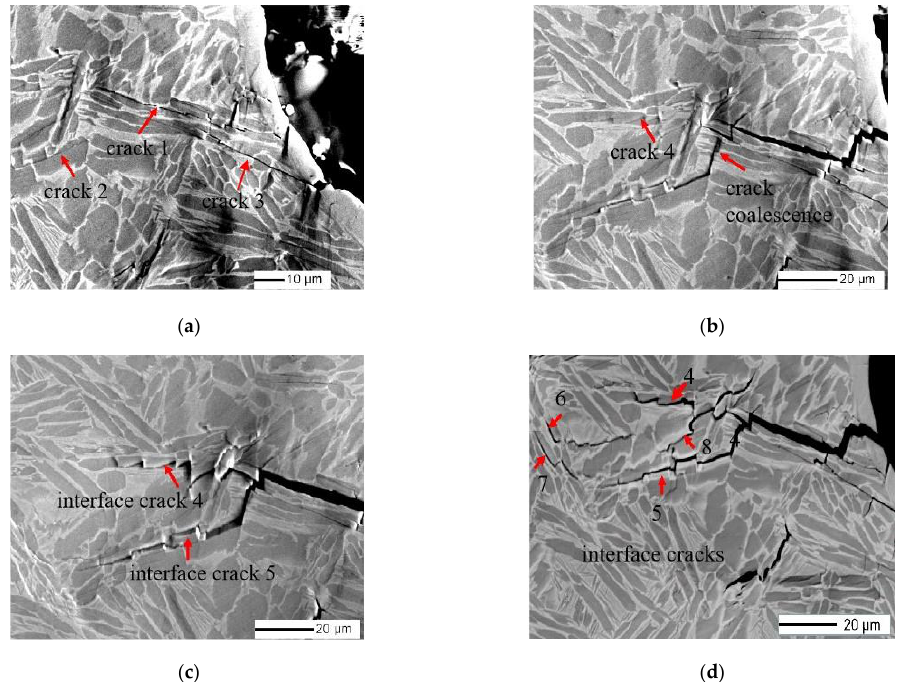
Figure 12 . Fatigue small cracks propagation process under maximum load of 1500 N. ( a ) N = 80 cycles. ( b ) N = 240 cycles. ( c ) N = 480cycles. ( d ) N = 600 cycles.